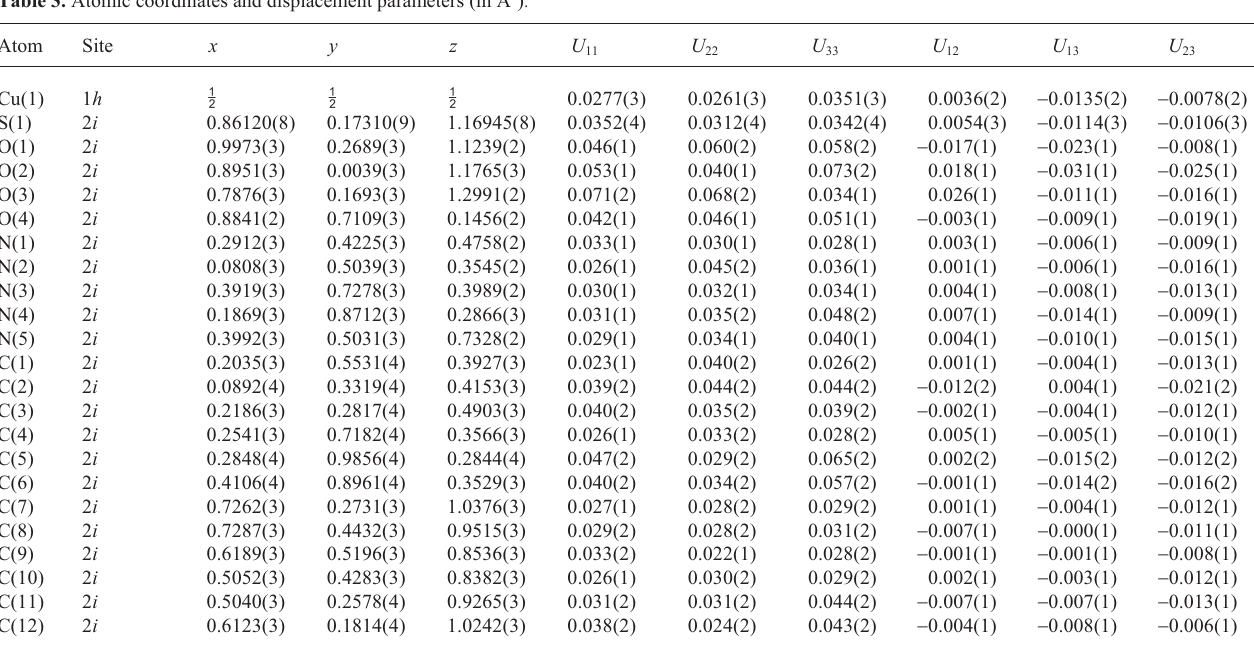
Table 3. Atomic coordinates and displacement parameters (in Å 2 ) .